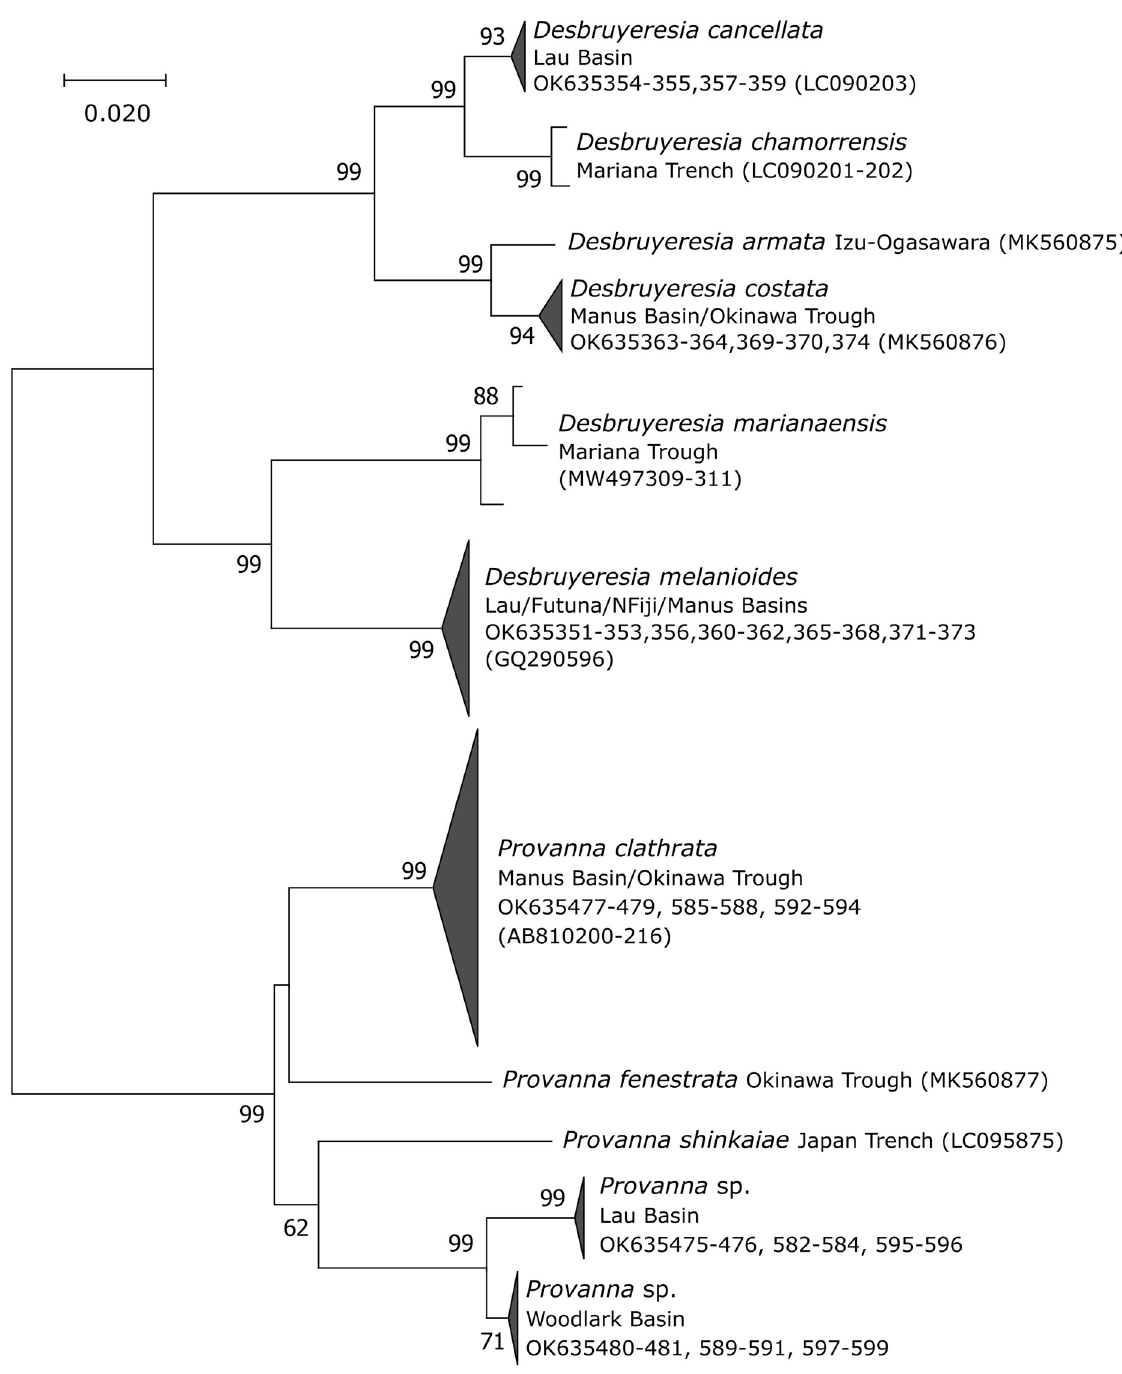
Fig 7. Cox1 Neighbor-Joining trees showing the position of individuals from Desbruyeresia and Provanna within their family. Number at nodes indicates the proportion of occurrences in 1000 bootstraps; percentages below 50% are not shown. Genbank accession numbers of the present study and published sequences are indicated. Published sequences are in brackets. Sequence lengths: 469 bp.